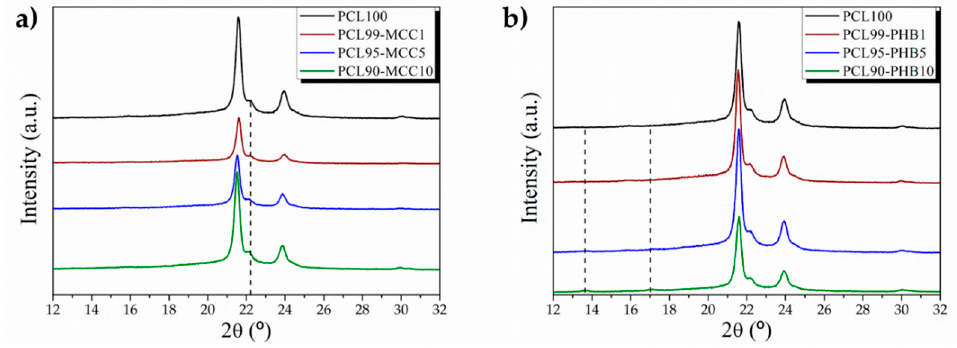
Figure 6. X-ray diffraction (XRD) curves of electrospun ( a ) PCL-MCC and ( b ) PCL-PHB mats.